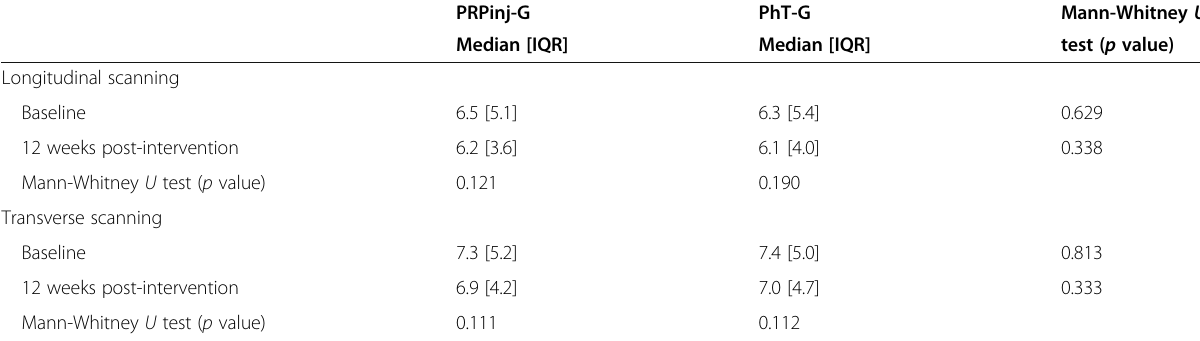
Table 5 Comparison of the supraspinatus partial tear size between the PRPinj-G and PhT-G at baseline and after 6 and 12 weeks post-intervention